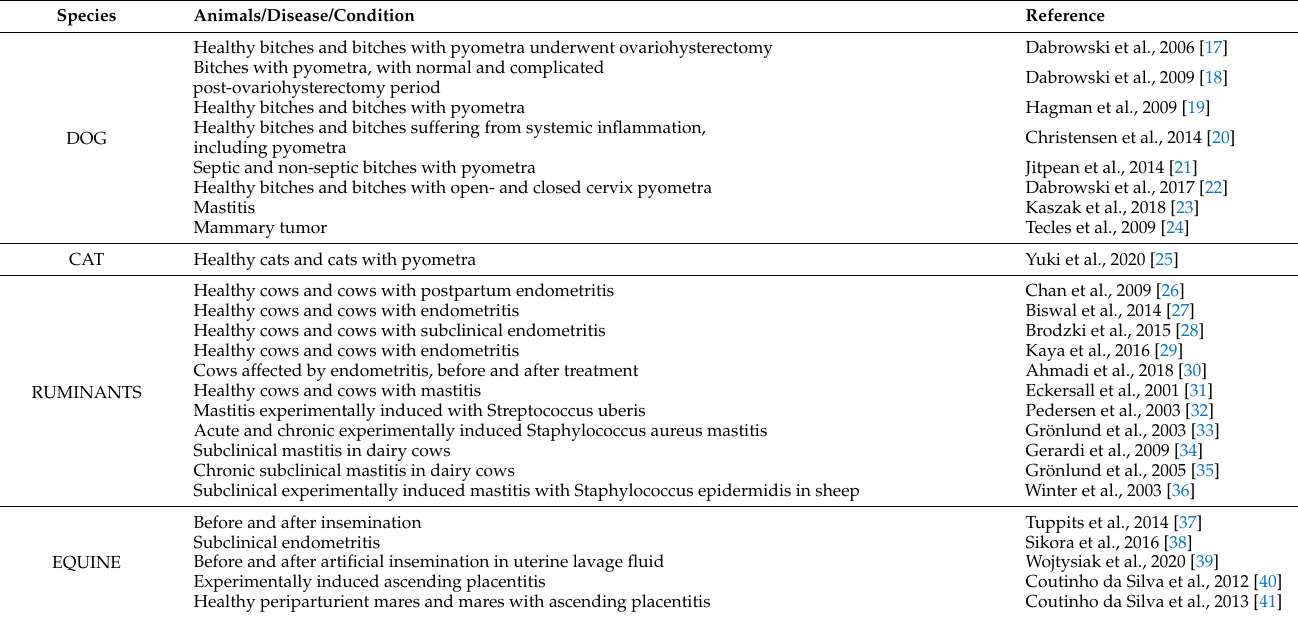
Table 1. Studies about serum amyloid A evaluation in pets, ruminants, and